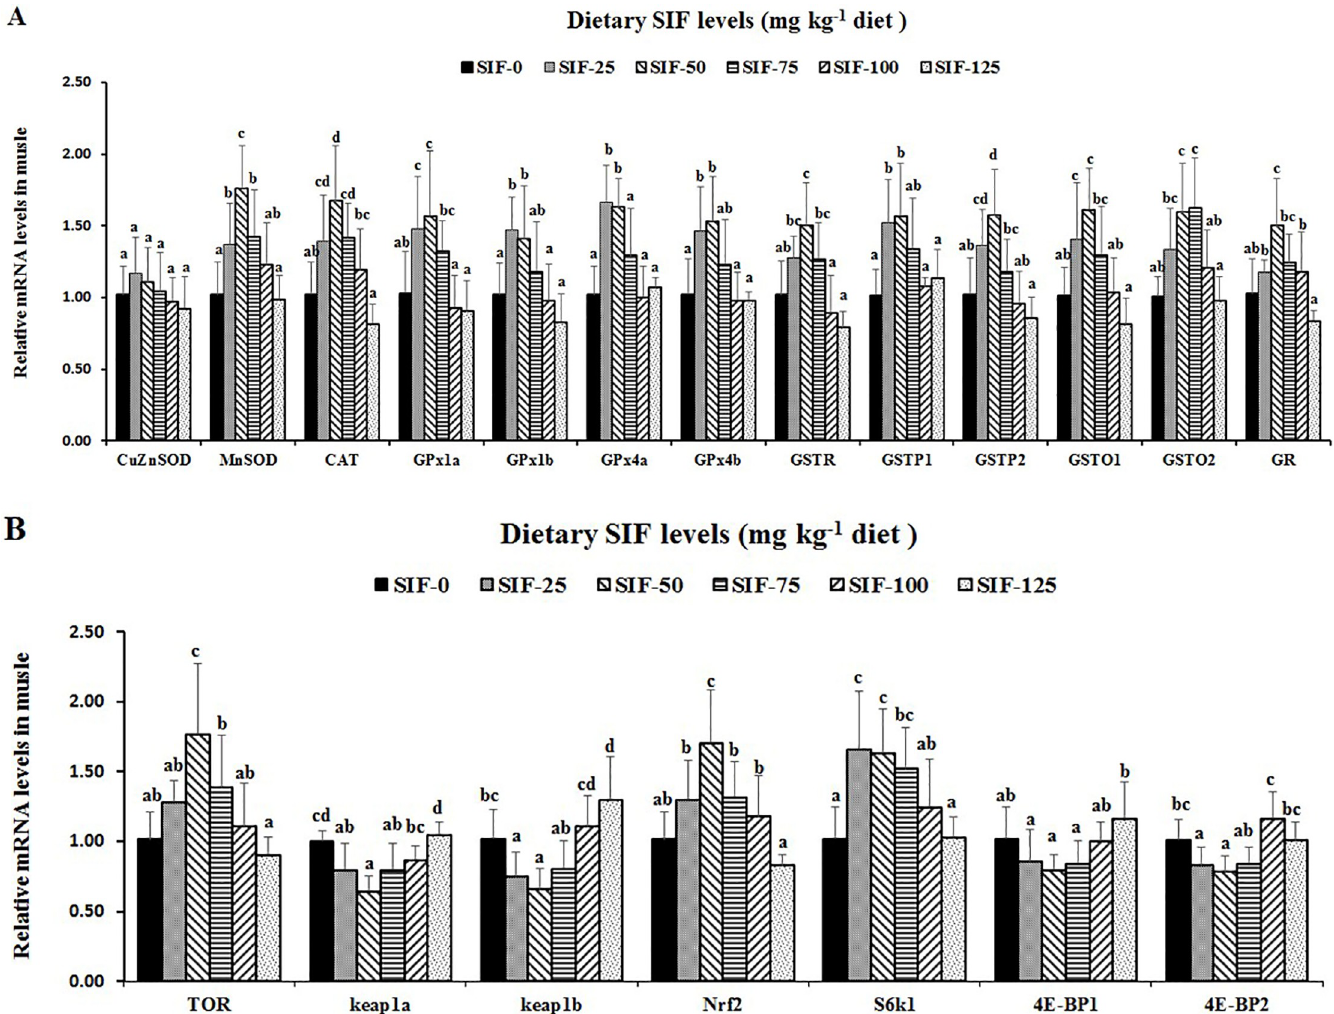
Fig 3. Effects of SIF on the antioxidative enzyme genes expression and signaling molecules in the muscle of grass carp. (A) CuZnSOD , MnSOD , CAT , GPx1a , GPx1b , GPx4a , GPx4b , GSTR , GSTP1 , GSTP2 , GSTO1 , GSTO2 and GR . (B) TOR , Keap1a , Keap1b , Nrf2 , S6K1 , 4E-BP1 and 4E-BP2 . Values are means (n = 6 for gene expression), error bars indicate SD, and different letters above a bar denote the significant difference between treatments ( P <